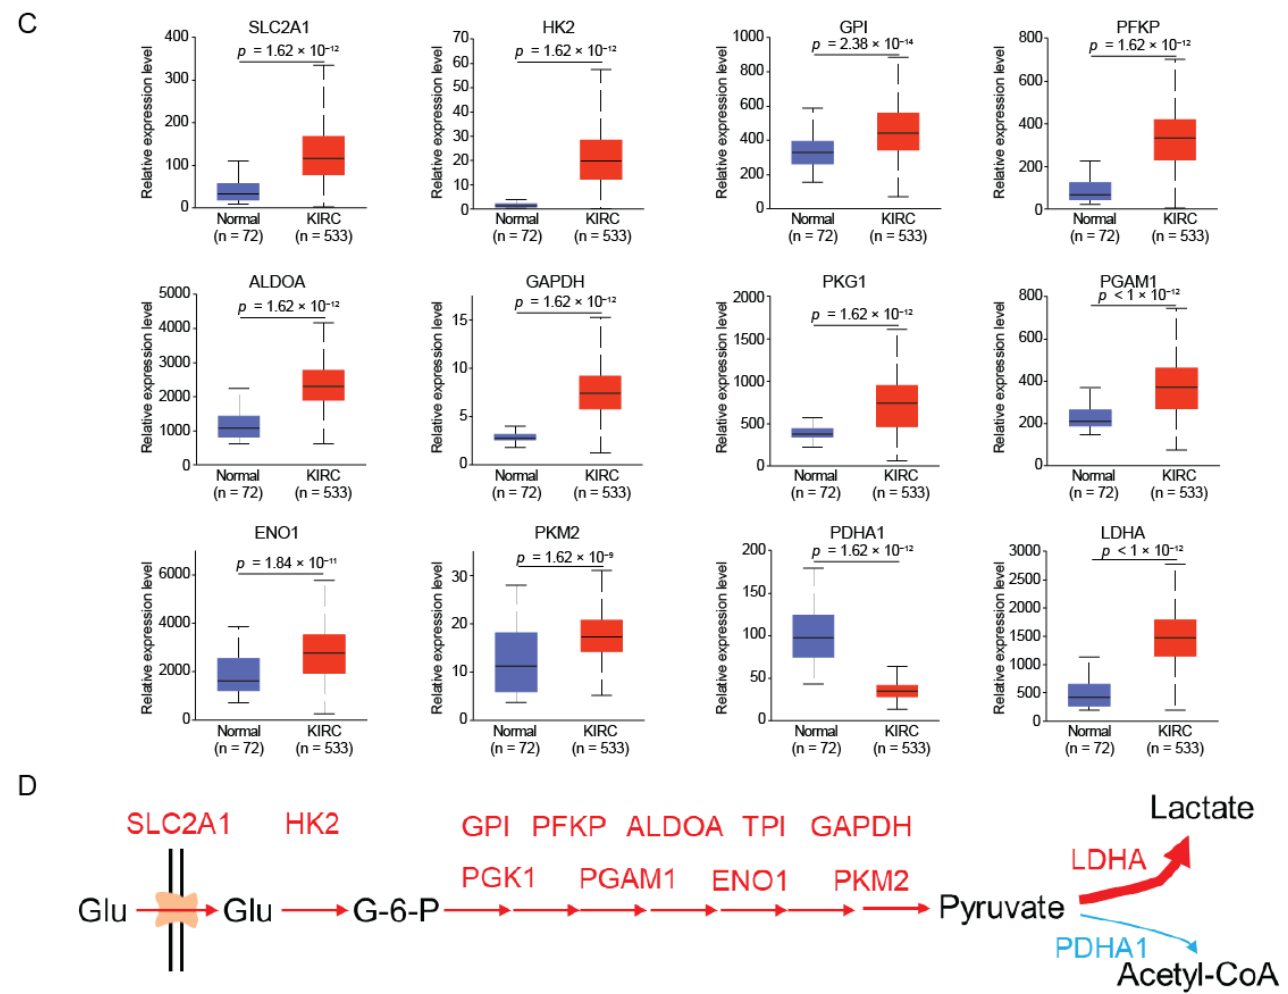
Figure 3. HGD/GSTZ1 promotes the conversion of glucose to lactate in KIRC. ( A , B ) GSEA pathway enrichment analyses of the key regulator (GOT1, GOT2, HGD, and GSTZ1) signature in patients with RCC from the TCGA datasets. ( C ) The glucose-metabolizing enzymes mRNA expression levels between tumor and normal tissues in patients with KIRC in TGCA database. ( D ) Schematic diagram of the glucose metabolism pathway.